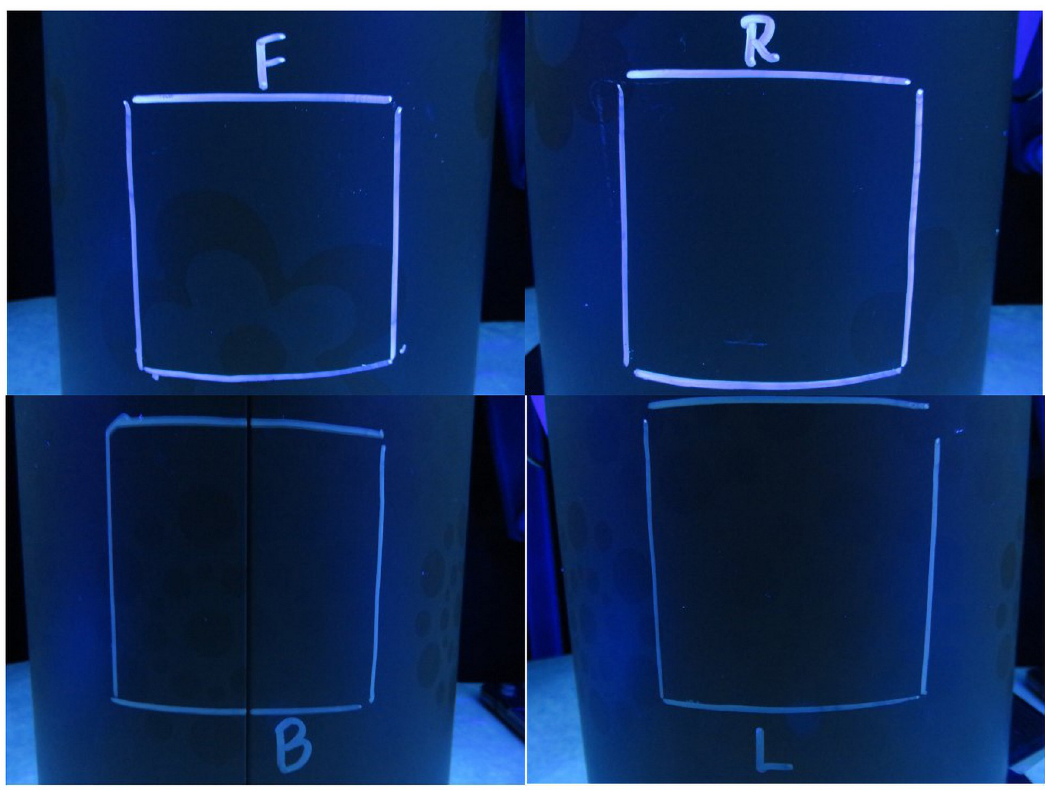
Fig 3. Example photographs for each quadrant of one of the controls (blank, unsprayed) trash cans. F = front of can; R = right side of can; B = back of can; L = left side of can.